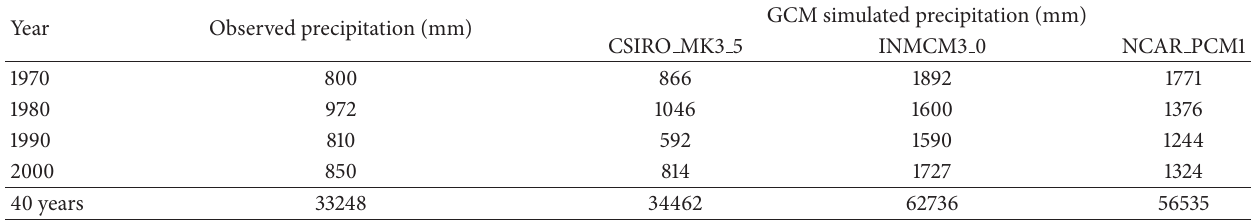
Table 7: Comparison of simulated and observed annual precipitation in the study